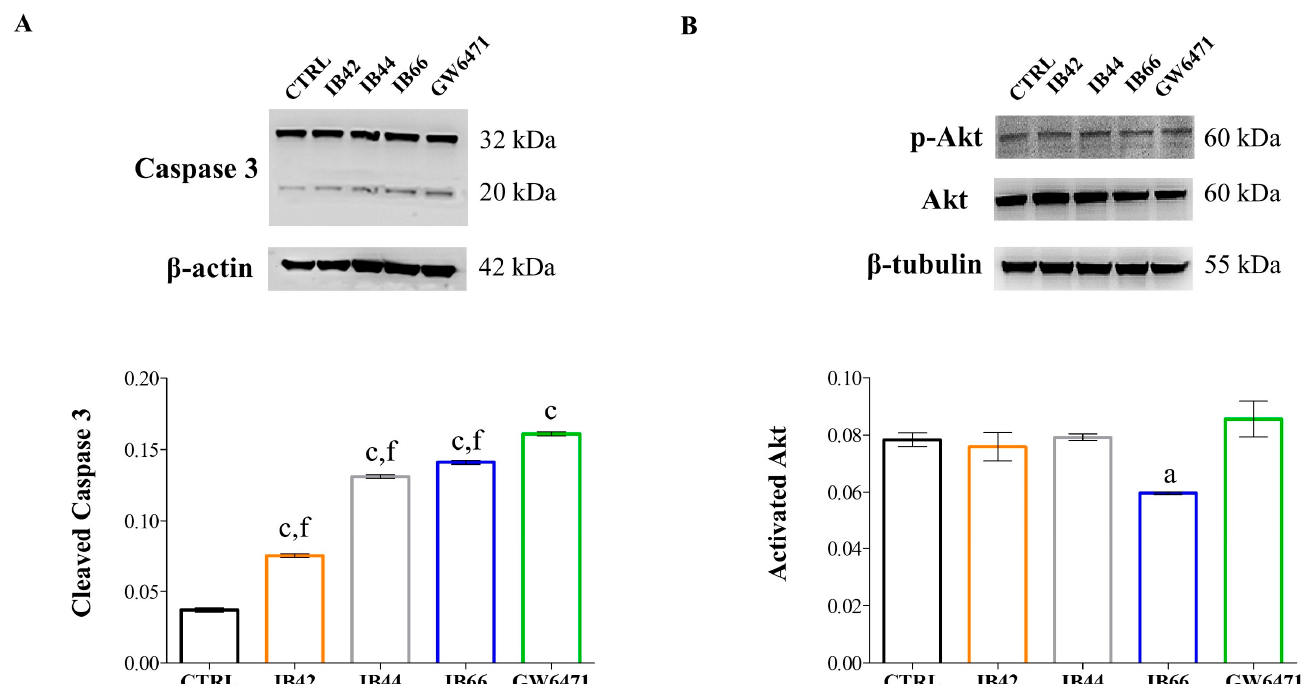
Figure 5. Apoptosis–pyroptosis occurrence in MCF7 cells in the presence of phenylsulfonimide derivatives at 3 µ M after 24 h. β -actin and β -tubulin are used as loading controls. ( A ) Western blot analysis of caspase 3. 32 kDa = full-length protein; 20 kDa = cleaved caspase 3. Bar graph displays densitometric values related to cleaved caspase expressed as mean densitometric measurements ± S.D. (n = 3) normalized on the ones of the loading control and on the ones of the full-length protein. ( B ) Western blot analysis of activated Akt (p-Akt, phosphorylated protein). The bar graph shows densitometric values related to activated Akt expressed as mean densitometric measurements ± S.D. (n = 3) normalized on the ones of the loading control and on the ones of the non-phosphorylated protein. CTRL = untreated control. a ( p < 0.01) and c ( p < 0.0001) between untreated cultures (CTRL) and treated samples. f ( p < 0.0001) between GW6471-treated cultures and samples in the presence of phenylsulfonimide derivatives.